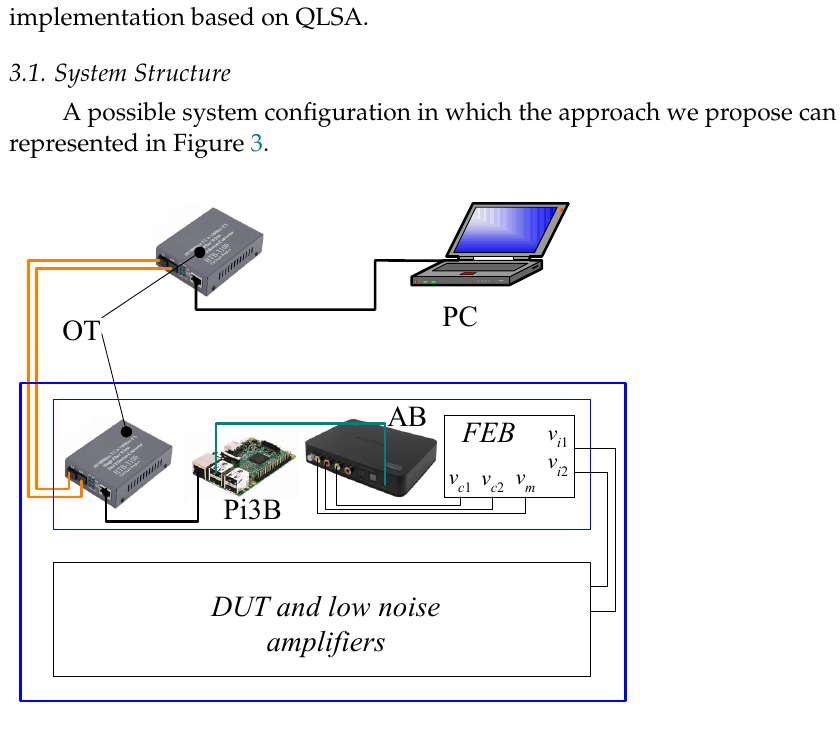
Figure 3. Block diagram of the implementation of the system according to the proposed approach. The square blue box represents the shielded environment in which the DUT, the low-noise electronics, and the Raspberry Pi3B based spectrum analyzer are enclosed for galvanic insulation from the external environment.